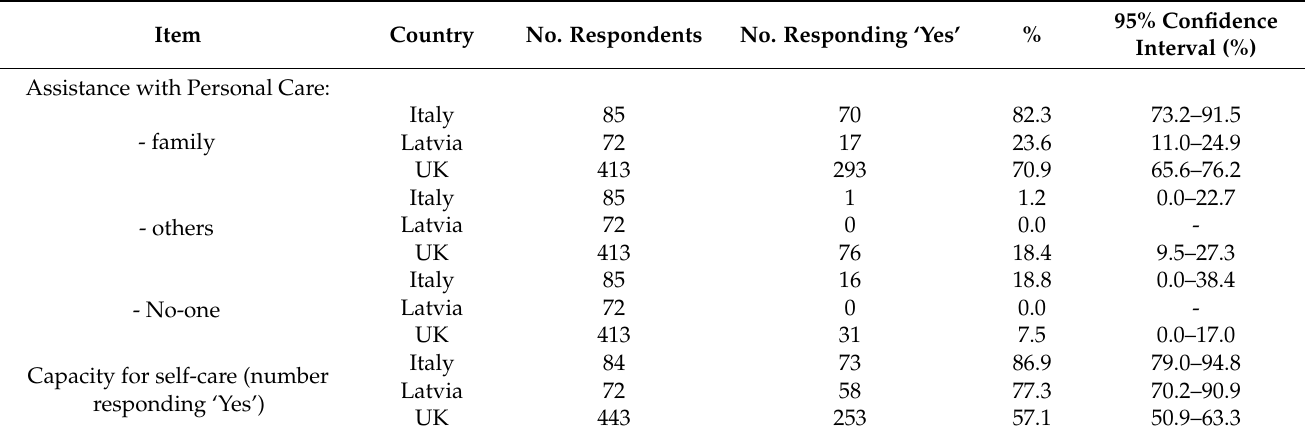
Table 6. Personal